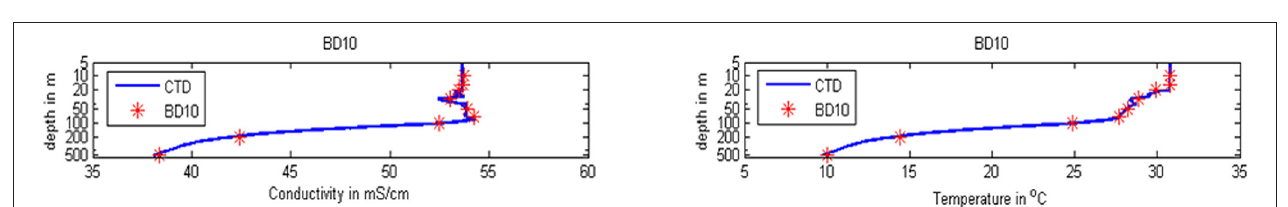
FIGURE 13 | Atmospheric pressure measured by buoy system.